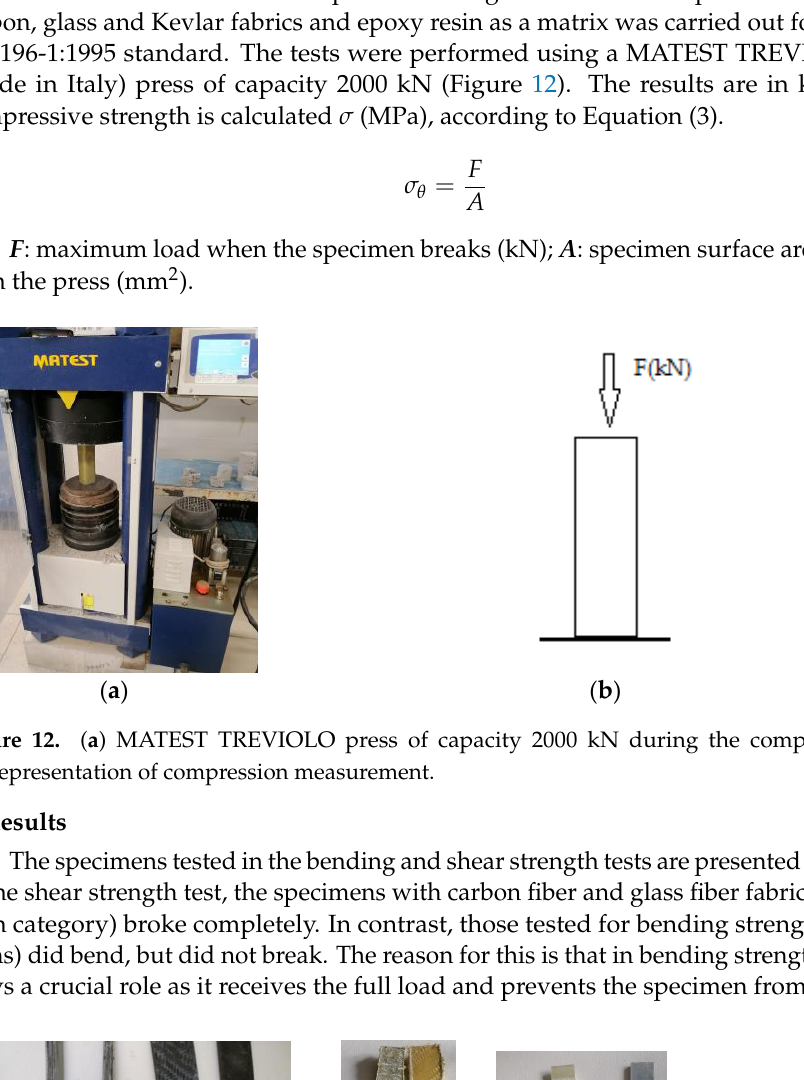
Figure 11. ( a ) Three-point scheme for the bending strength measurement; ( b ) three-point scheme for the shear strength measurement.